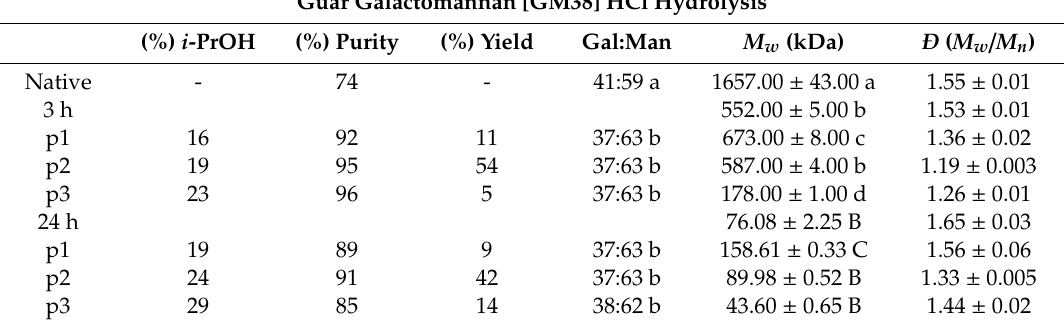
Table 3. M w and Ð variation of GM38 during 3 and 24 h acid hydrolysis before and after i -PrOH precipitation, with p1, p2, and p3 being the polysaccharide fractions collected during stepwise addition of i -PrOH # . Guar Galactomannan [GM38] HCl Hydrolysis